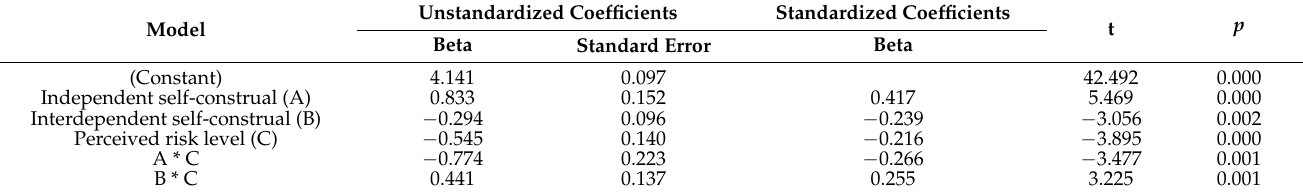
Table 5. Results of use intention regression analysis on different self-construals and perceived risk level.